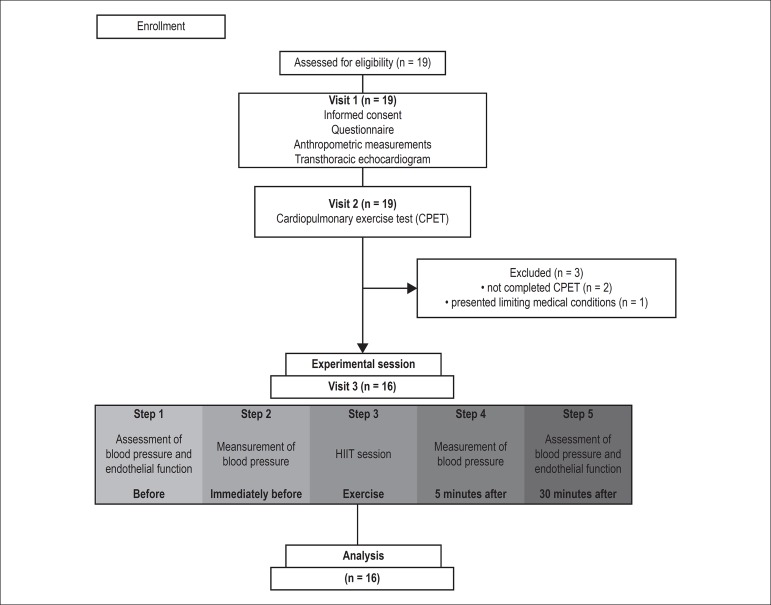
Study flow diagram.